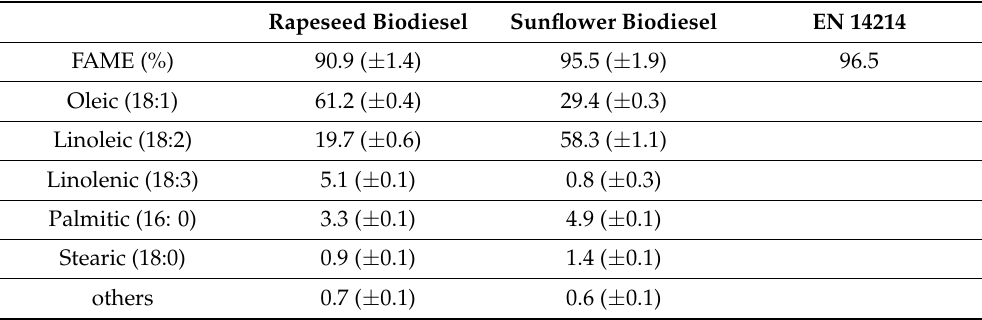
Table 1. Total FAME and composition of rapeseed and sunflower biodiesel. The average value with S.D. is reported ( n = 3). Rapeseed Biodiesel Sunflower Biodiesel EN